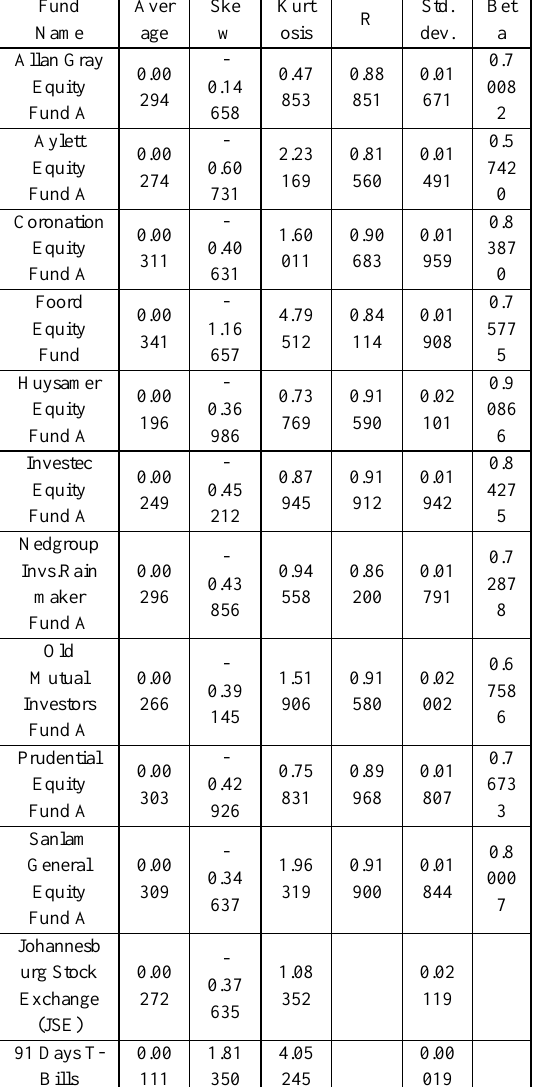
Table 2. Descriptive Statistics of South African Mutual